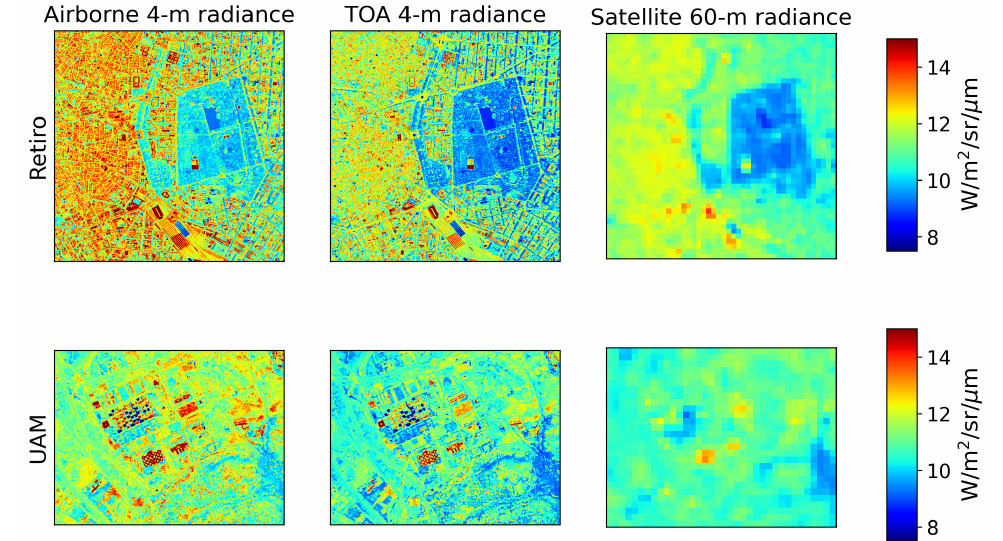
Figure 5. Illustration of the methodology applied on one thermal band (72) over the Retiro Park ( up ) and the UAM ( bottom ): before Step 1 ( left ), after Step 1 ( middle ), after Step 2 ( right